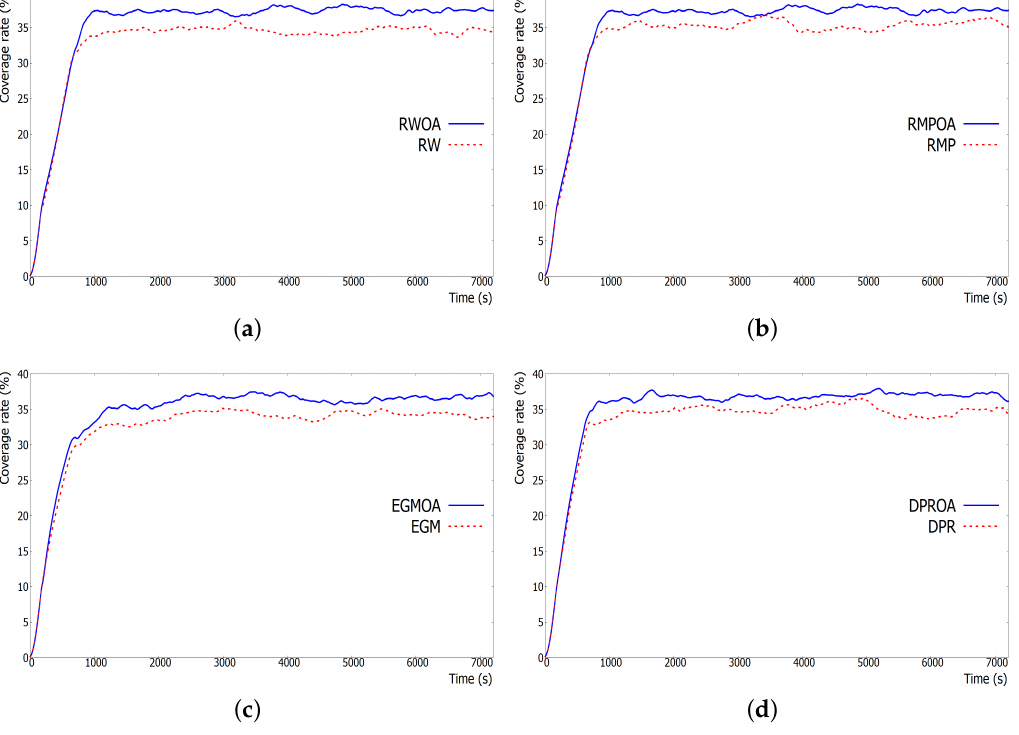
Figure 9. The interval coverage rate results with/without Overlap Avoidance: ( a ) Random Waypoint; ( b ) Random Markov Process; ( c ) Enhanced Gauss–Markov; and ( d ) Distributed Pheromone